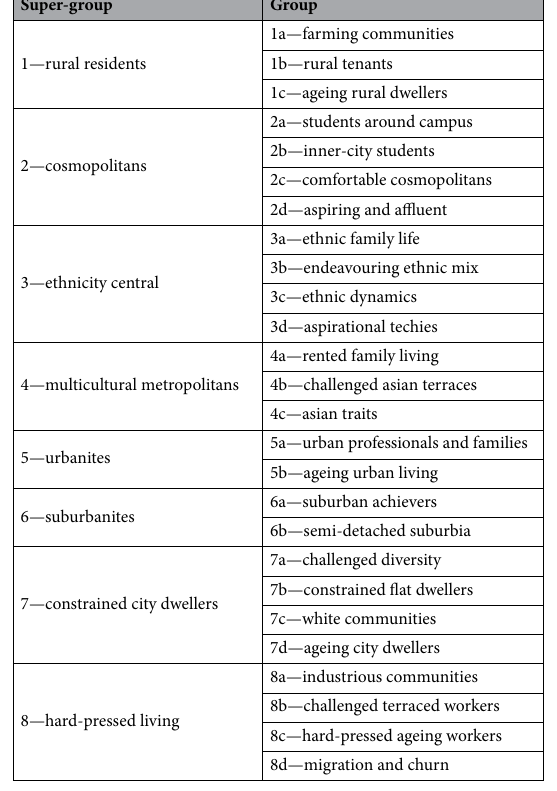
Table 1. Area classification for output area (OAC) cluster names 41 .